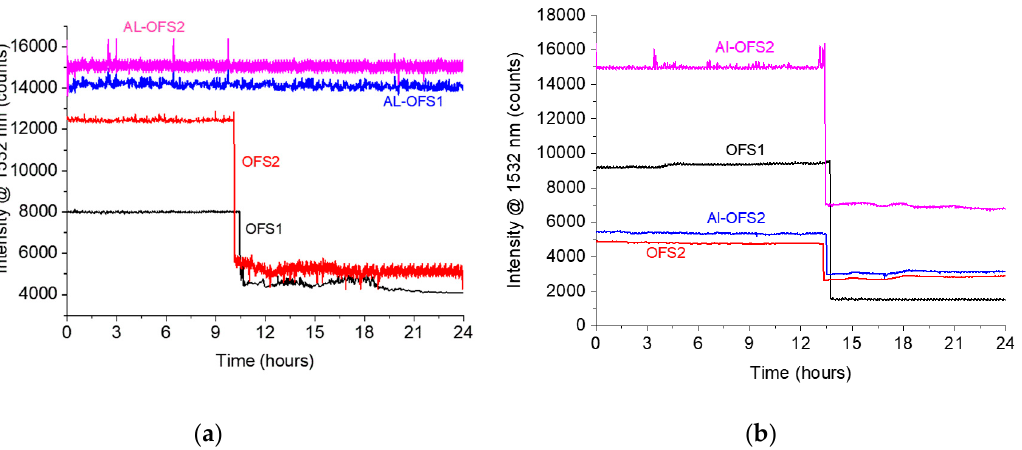
Figure 7. Signal intensity at a wavelength of 1532 nm from sensors embedded in the epoxy exposed to ( a ) artificial sea water and ( b ) HCl. The aluminum optical fiber sensors (Al-OFS) are sensitive to HCl, whereas they do not exhibit any response to artificial sea water.